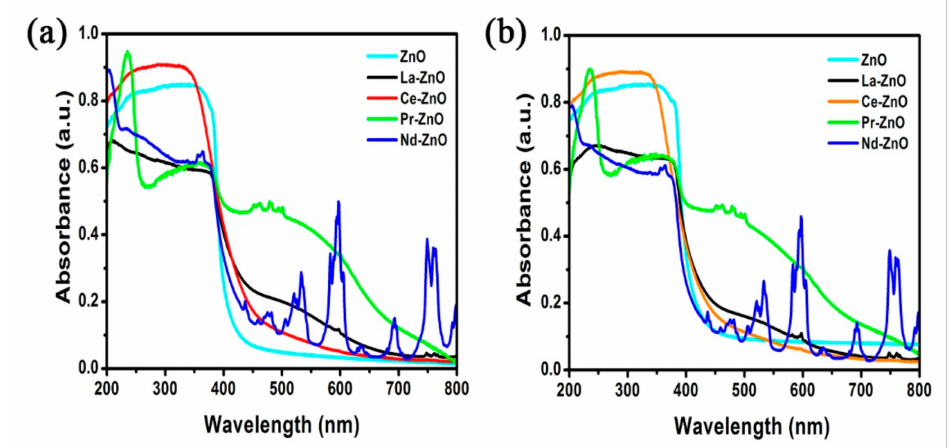
Figure 5. UV–Vis DRS of ZnO and M-ZnO (M = La 3+ , Ce 3+ , Pr 3+ and Nd 3+ ) nanoparticles: ( a ) calcined to 500 ◦ C and ( b ) calcined to 700 ◦ C.